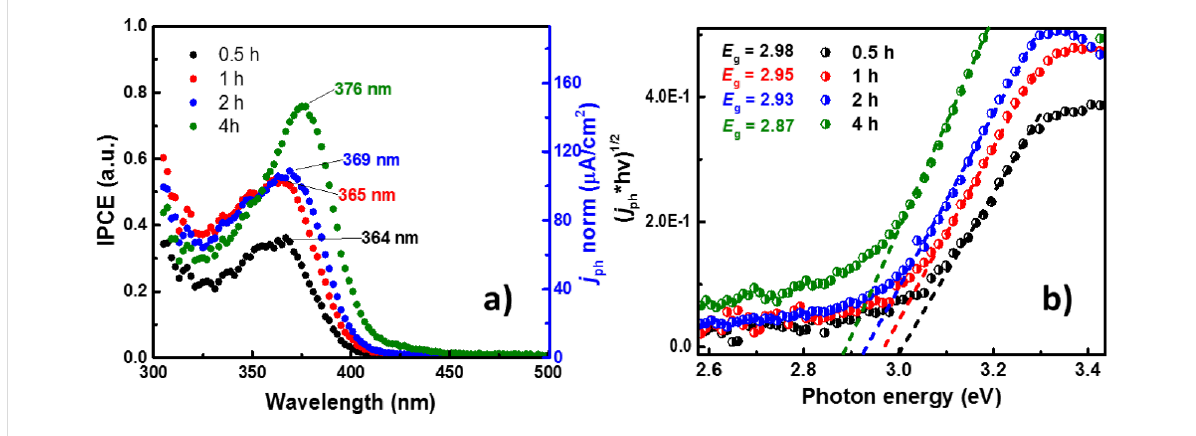
Figure 7: (a) Incident photon-to-current (IPCE) plot for each TNT. (b) Tauc plots for a direct electronic transition. Conditions: E = 1.0 V/RHE, 0.5 M H 2 SO 4 , 20 min N 2 bubbling and irradiation power = 20 mW/cm 2 .